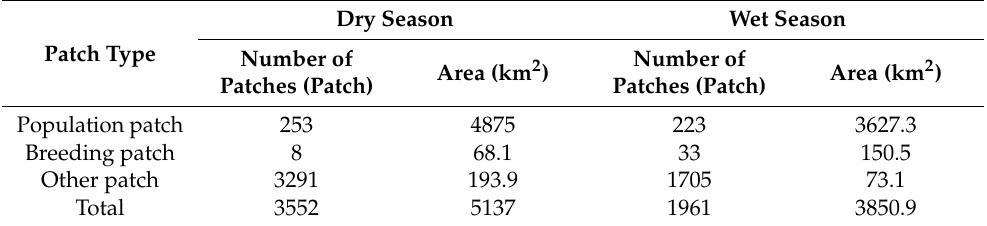
Table 3. Habitat patch of wild elephant in the eastern part of Thailand in 2020. Patch